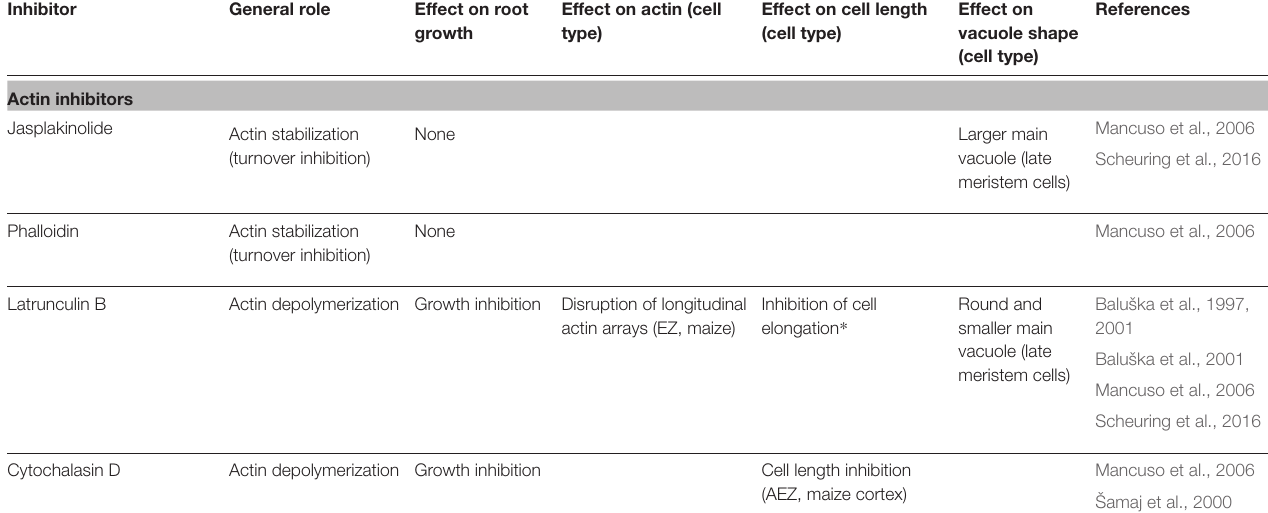
TABLE 1 | Inhibitor effect on root growth, cell expansion, vacuolar shape, and actin organization and dynamics.